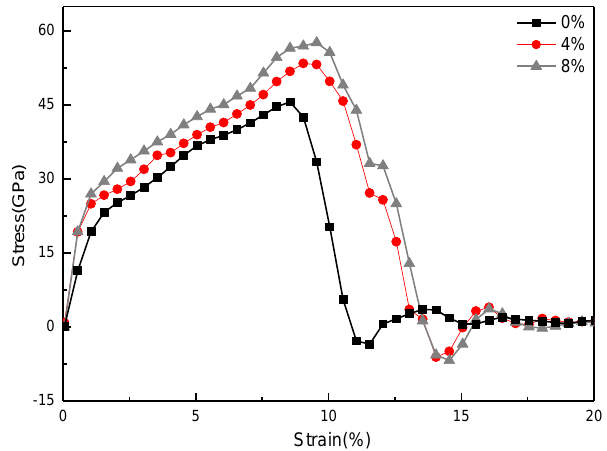
Figure 8. Stress-strain curve of CNCs-graphene layered structure with different covalent bond contents.